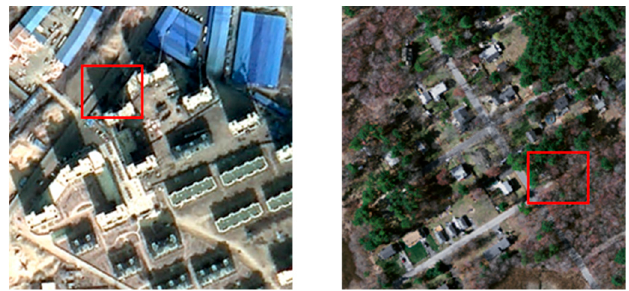
Figure 1. Instances of roads blocked by obstacles (red rectangles). Left: shadow occlusion; Right: visual occlusion.